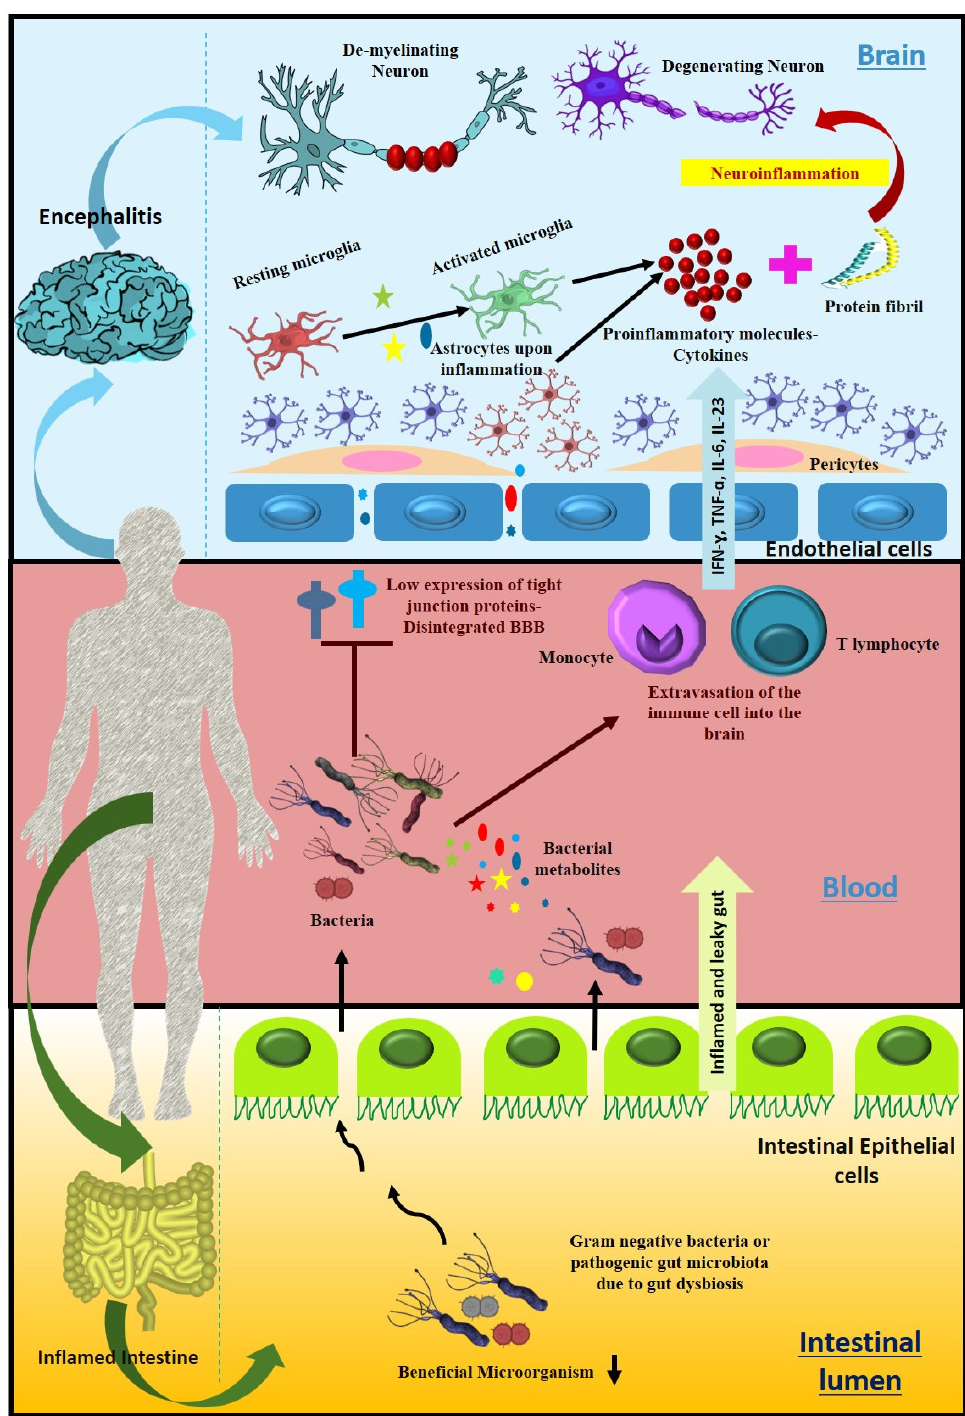
Figure 4. Probable mechanism of gut microbial population and their metabolites to cause neuroinflammation. Intensification and accumulation of pathogenic gut microbiota due to dysbacteriosis lead to the formation of an inflamed and leaky gut. Microbes and their associated metabolites can enter the peripheral circulatory system, where they further lower the expression of tight junction proteins in brain endothelial cells and lead to the disintegration of the blood–brain barrier that promotes the entrance of pathogenic microbes, some of them carrying prions into the brain. Meanwhile, microbial metabolites stimulate the extravasation of immune cells into the brain, all of which together trigger cytokine storm, the cause of neuroinflammation, one of the important hallmarks of neurological disorders characterized by degenerated and demyelinated neurons.